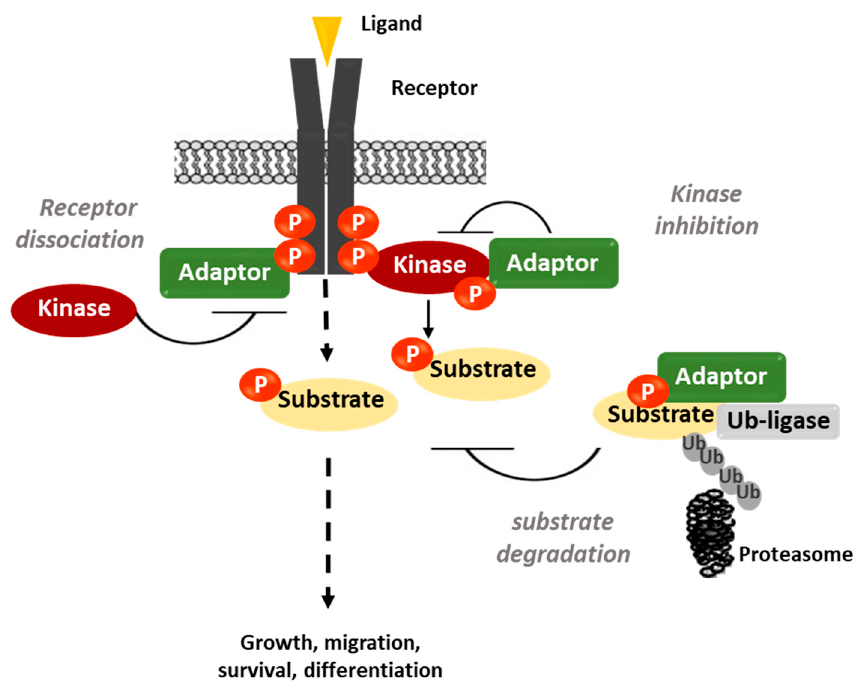
Figure 1. A model showing the negative control of tyrosine kinase (TK) signalling by small adaptors. Adaptor proteins can inhibit TK signalling by competing with effectors for receptor binding, directly inhibiting cytoplasmic TK (CTK) activity or promoting substrate/CTK/receptor degradation via association with specific ubiquitination factors. Ub, ubiquitin; P, phosphorylation.